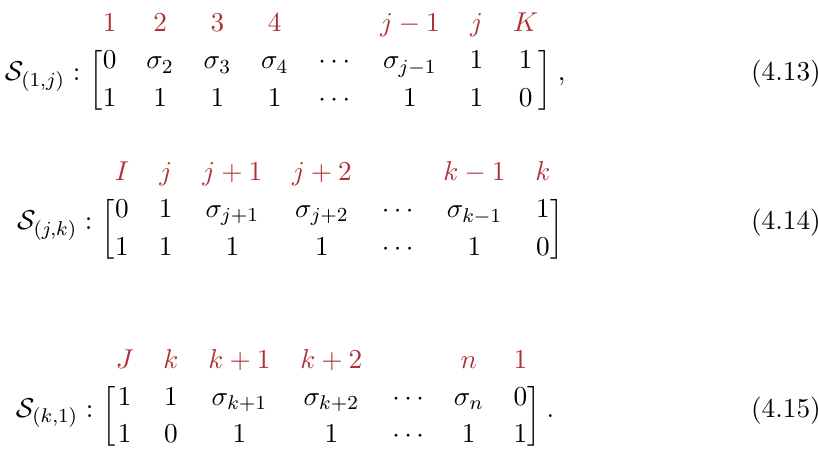
Figure 8 . General form of the matrix A [1 k ] play the role in its